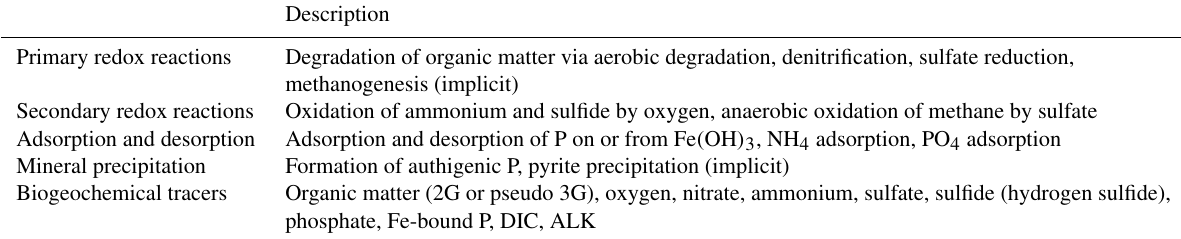
Table 1. Reactions and biogeochemical tracers implemented in the reaction network of OMEN-SED. The primary and secondary redox reactions are listed in the sequence they occur with increasing sediment